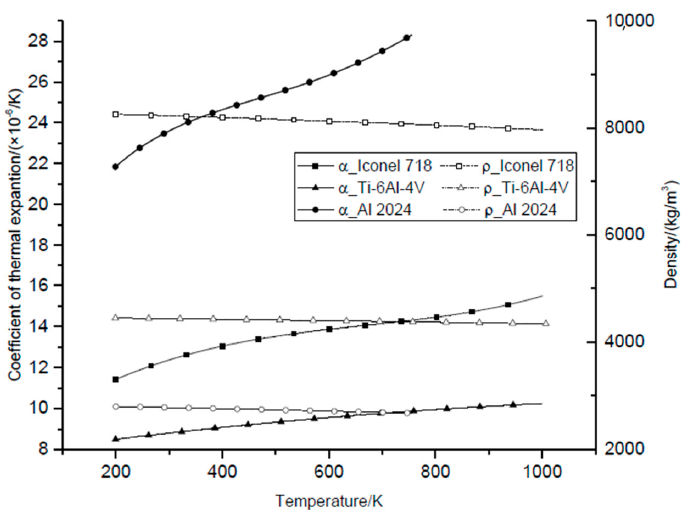
Figure A2. Coefficient of thermal expansion and density of materials varying with temperature.